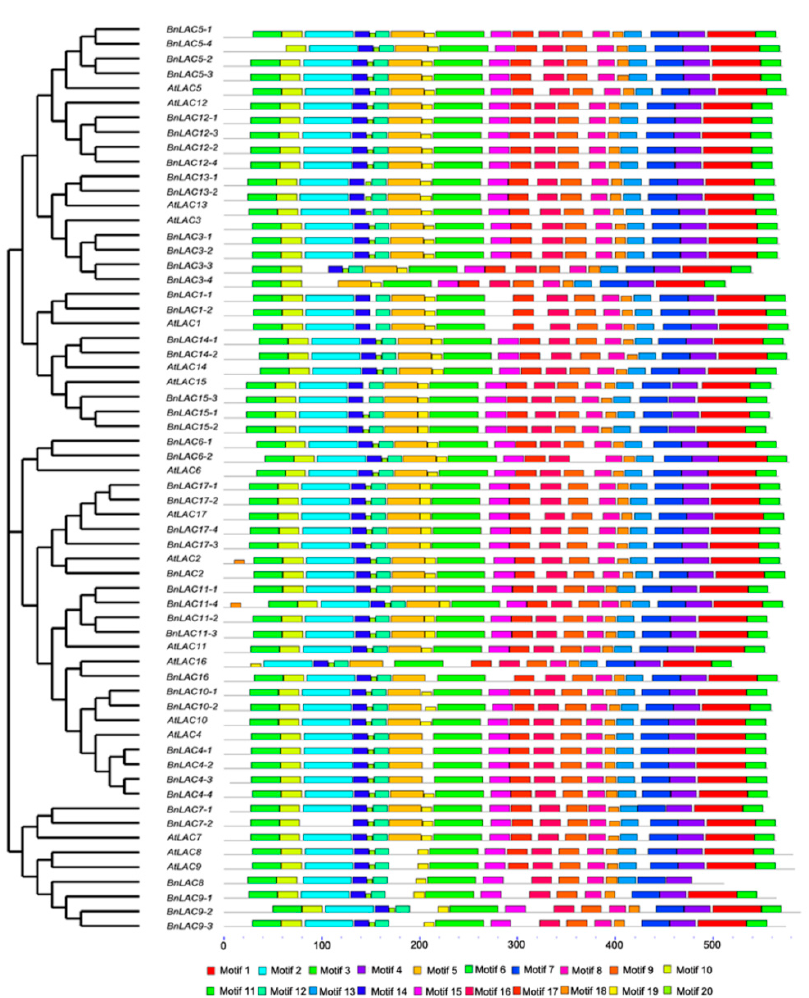
Figure 6. Conserved motif analysis of BnLACs and AtLACs proteins presented with a cladogram. Conserved motifs were generated by MEME 5.0.4 (http://meme-suite.org/tools/meme) and boxes of different colors represent motifs 1-20. Motif sequences are provided in Table S1.